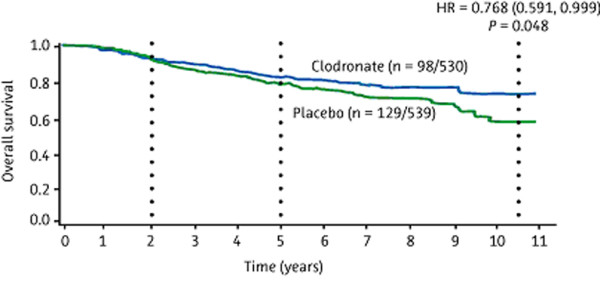
Overall survival in all patients. HR, hazard ratio.